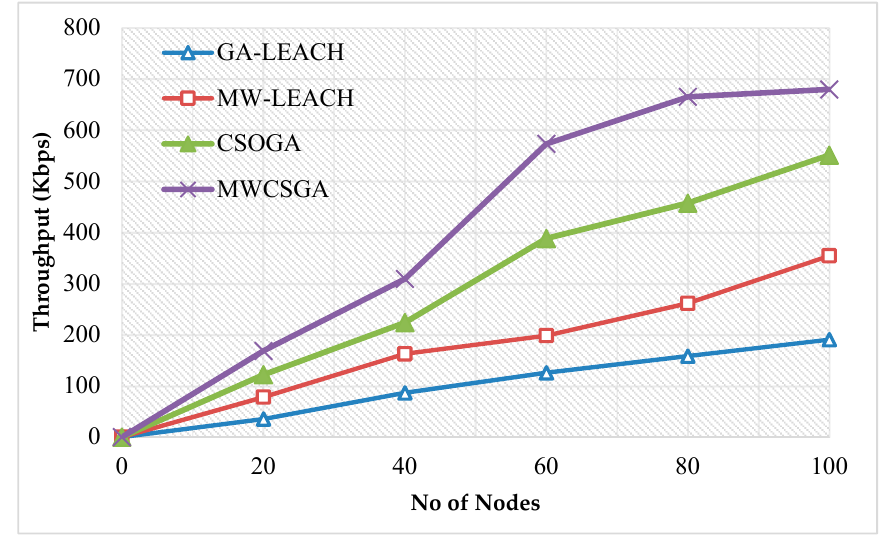
Figure 13 . Throughput calculation. Figure 13. Throughput calculation.